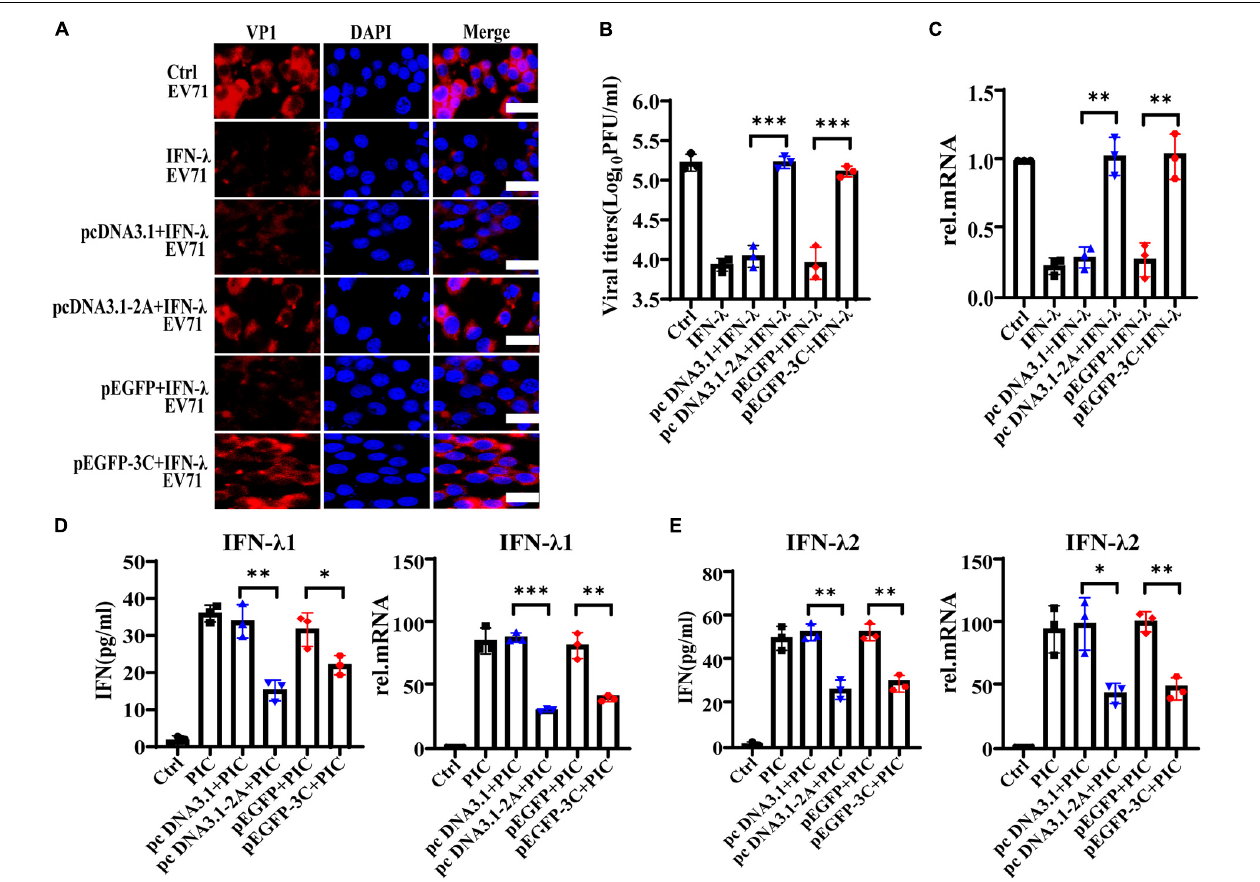
FIGURE 4 | The 2Apro and 3Cpro of EV71 antagonize the antiviral function of IFN- λ and inhibit the expression level of IFN- λ induced by poly(I:C). HT29 cells were transfected with pcDNA3.1-2A (control plasmid: pcDNA3.1) or p-EGFP-3C (control plasmid: p-EGFP). After transfection 24 h, cells were treated with IFN- λ (10 ng/ml) 6 h before infection. Then cells were infected with EV71 at an MOI of 1. Cells and culture mediums were collected at 24 hpi. (A) The protein expression level of VP1 was determined by incubating with anti-EV71 VP1 antibody, followed by staining with Alexa Fluor 555-conjugated secondary antibody. (B) The mRNA expression levels of VP1 were determined by qRT-PCR. (C) Cell culture medium was prepared for virus titer analysis. Control was cells with infected only. IFN- λ group was cells infected and using IFN- λ pretreatment. (D,E) HT29 cells were transfected with pcDNA3.1-2A (pcDNA3.1) or p-EGFP-3C (p-EGFP), and after transfection 24 h, cells were treated with poly(I:C) (4 µ g/ml). Cells and culture mediums were collected 24 h after stimulation. The protein expression levels of IFN- λ 1 and IFN- λ 2 were determined by ELISA, and the mRNA expression levels were determined by qRT-PCR. Control was cells without any treatment. PIC group was cells stimulated only by poly(I:C). Dates were presented as mean ± SD ( n = 3 independent experiments, ∗ P < 0.05, ∗∗ P < 0.01 and ∗∗∗ P <